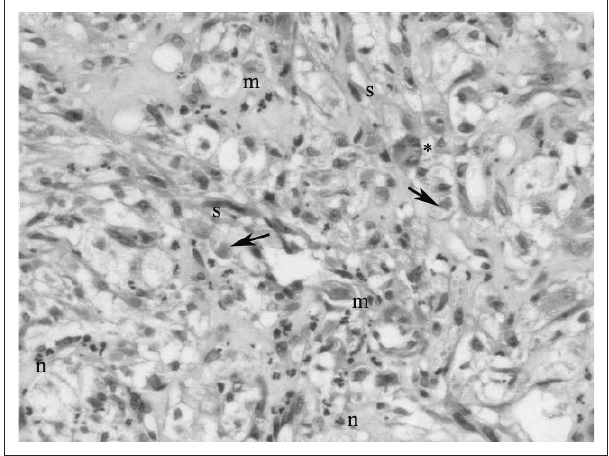
Source : Photo provided by Dr J.H. Voster Note: intra-cytoplasmic inclusions (arrows) Nodular subcutaneous lesions composed of macrophages, spindle cells and a few multinucleate cells and Neutrophils intra-cytoplasmic inclusions are also evident. Haematoxylin and Eosin x 200. M, macrophages; s, spindle cells; *, multinucleate cells; n, neutrophils. FIGURE 2: Yaba monkey tumour virus infection in a vervet monkey.